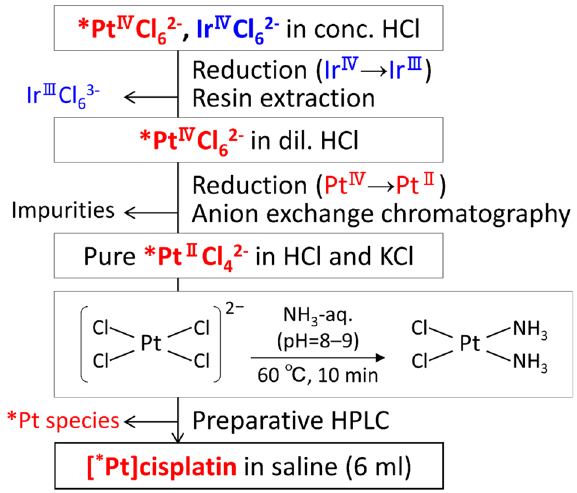
Figure 1. Scheme for preparation of *Pt II Cl 42− and synthesis of